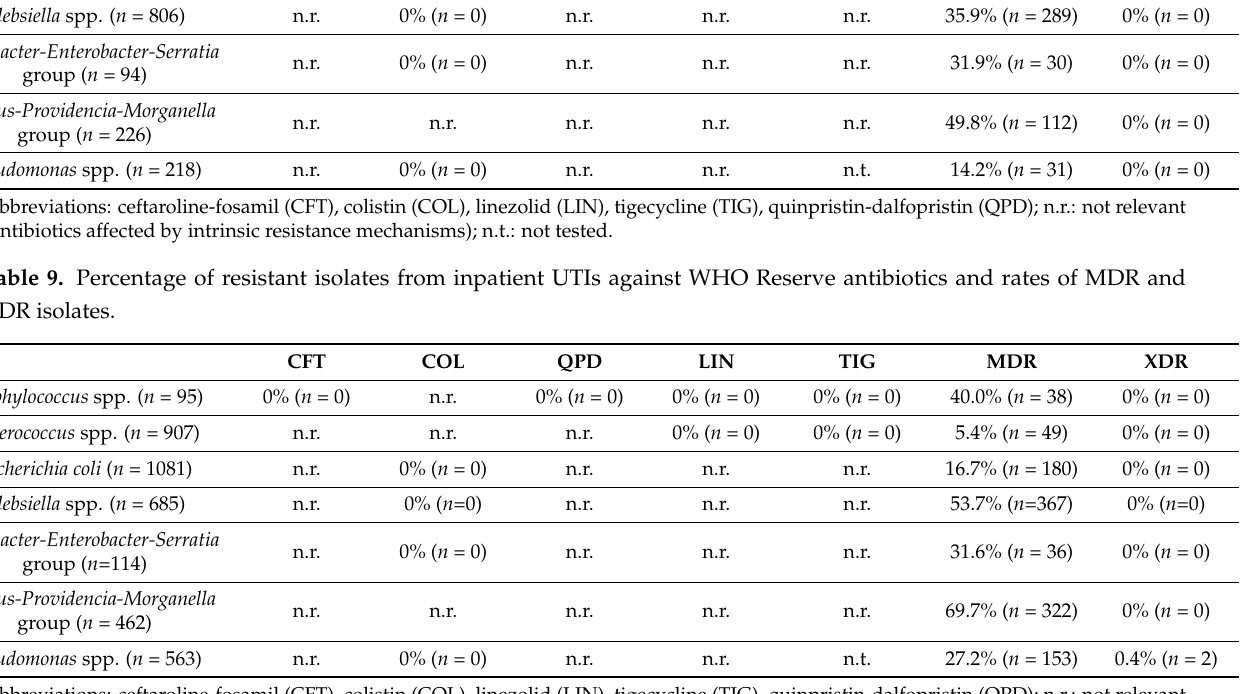
Klebsiella spp. ( n =